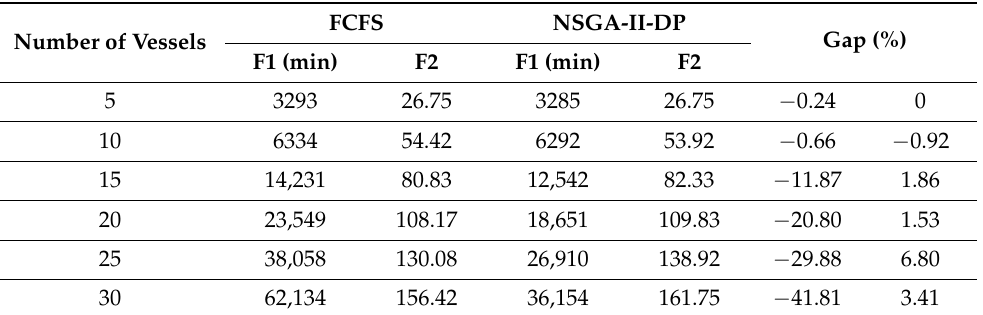
Table 10. Results of applying the traditional FCFS strategy and the NSGA-II-DP algorithm to different numbers of